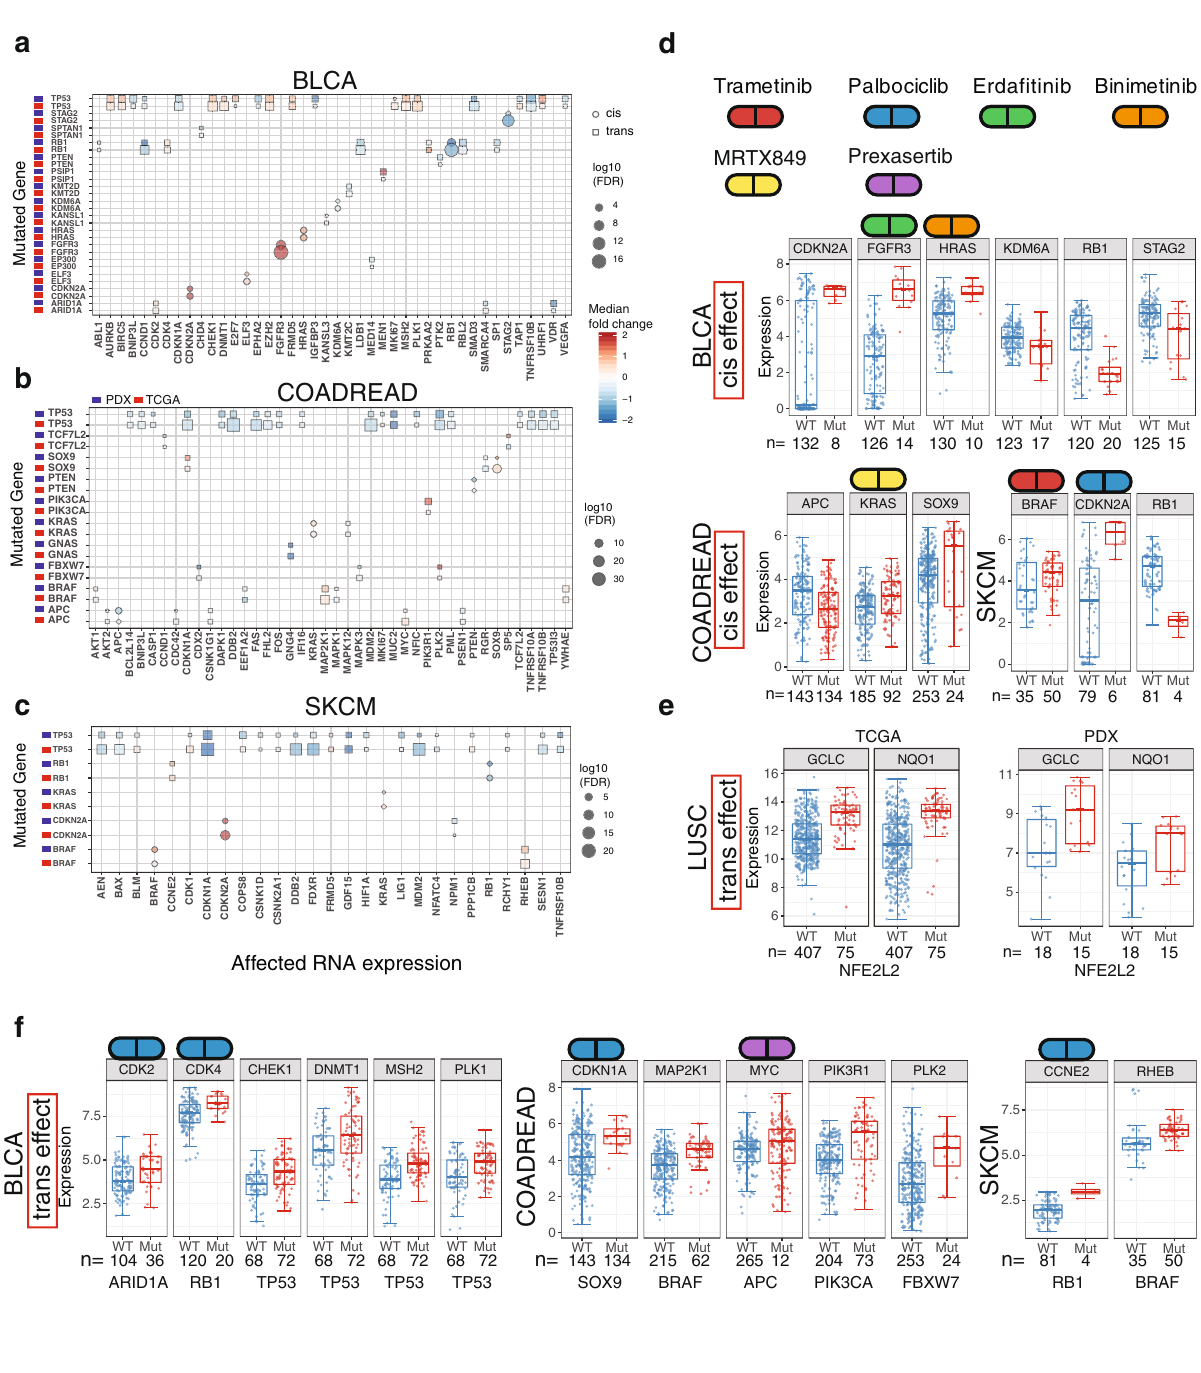
Fig. 3 Cis and trans effect of driver mutations on gene expression. a – c Cis and trans effect of driver mutations on RNA expression from TCGA tumors and PDXs on three different cancer types: bladder (BLCA), colorectal (COADREAD), and skin cutaneous melanoma (SKCM). Boxplots for the cis effect ( d ) and trans effect ( e , f ) of key driver genes on gene expression. Number of samples (n) for each group is shown in the fi gure. The box boundary of each box plot indicates third quartile and fi rst quartile respectively from the top to bottom. The whisker on top were drawn out from the third quartile to the largest data point or up to 1.5 × IQR. Similarly, the bottom whisker extends from the fi rst quartile down to 1.5 × IQR or the lowest data point. The red dot at the center indicates medium. Source data are provided as a Source Data fi